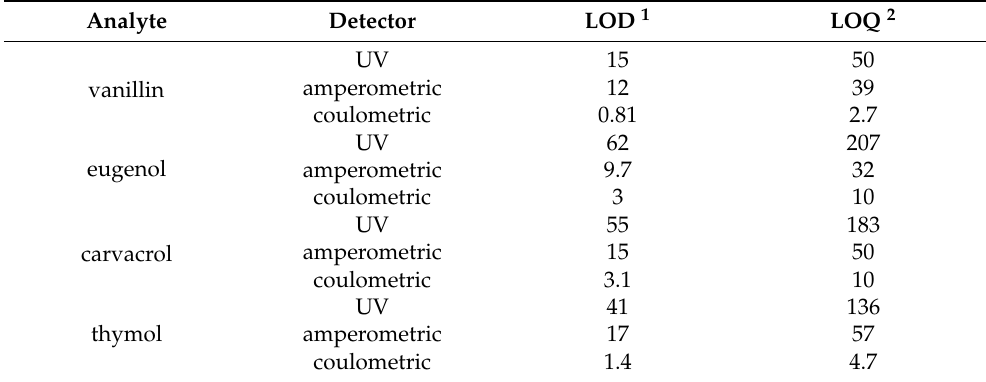
Table 7. LODs and LOQs ( µ g L − 1 ) of UV, amperometric and coulometric detectors. Analyte